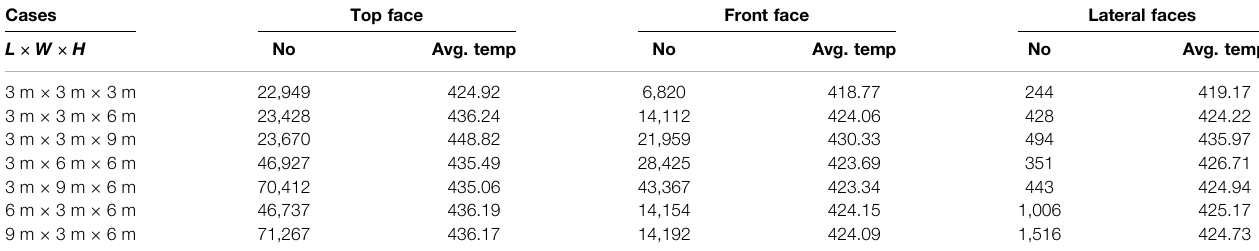
TABLE 3 | Number and average temperature (K) of fi rebrands deposited on the top, front and lateral faces of the structure. Cases Top face Front face Lateral faces L × W × H No Avg.